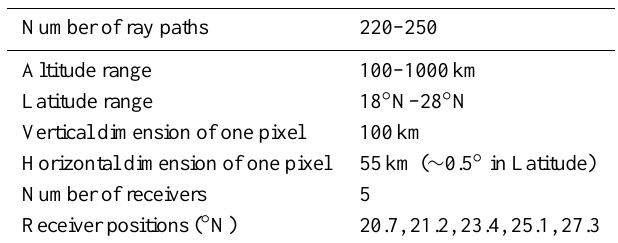
Table 1. The geometry used for low-latitude ionosphere reconstruc-